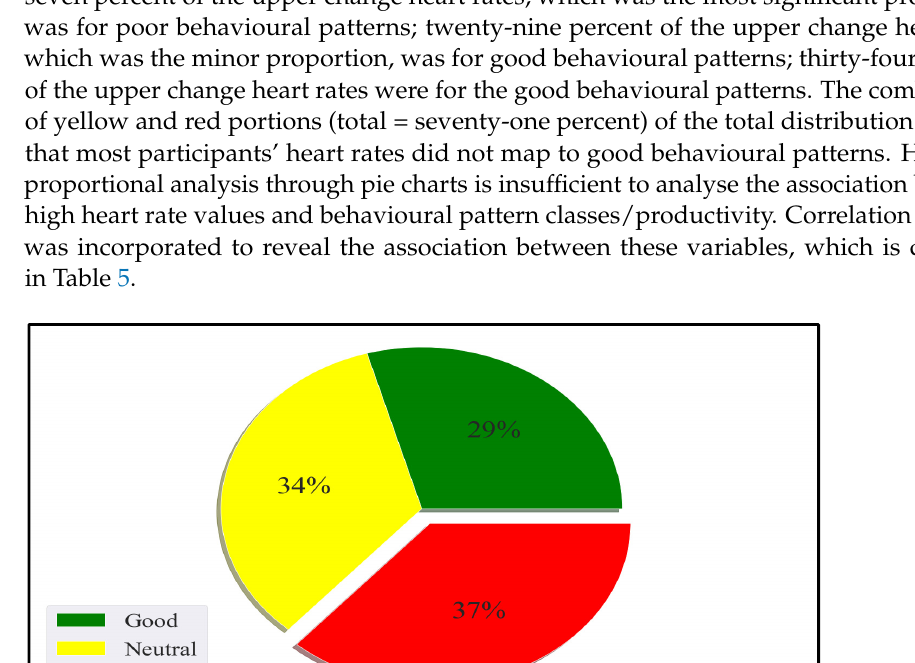
Table 6. Correlation summary ( − 1 ≤ r ≤